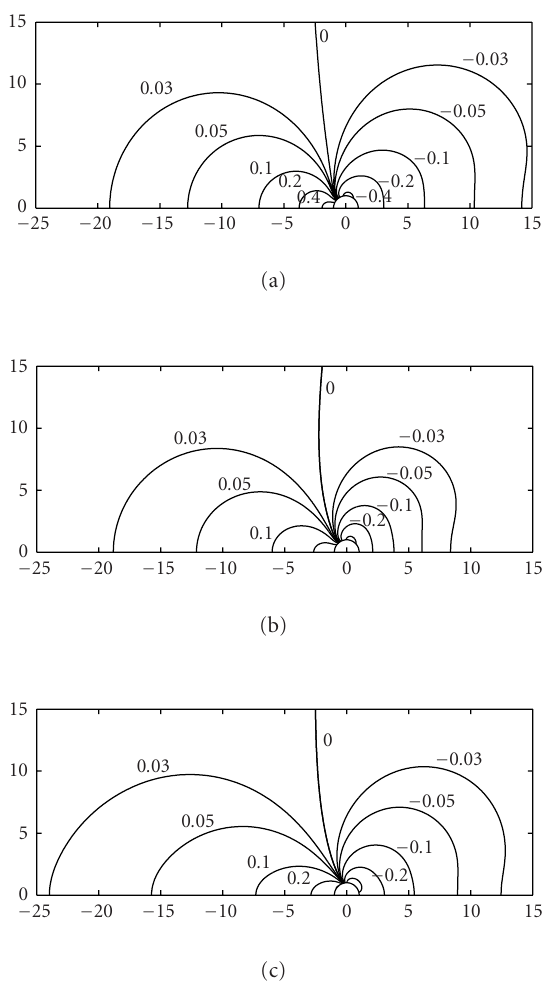
Figure 4.10 . Pressure fields for the flow with Re = 20. (a) N = 0, (b) N = 1, and (c) N = 12.